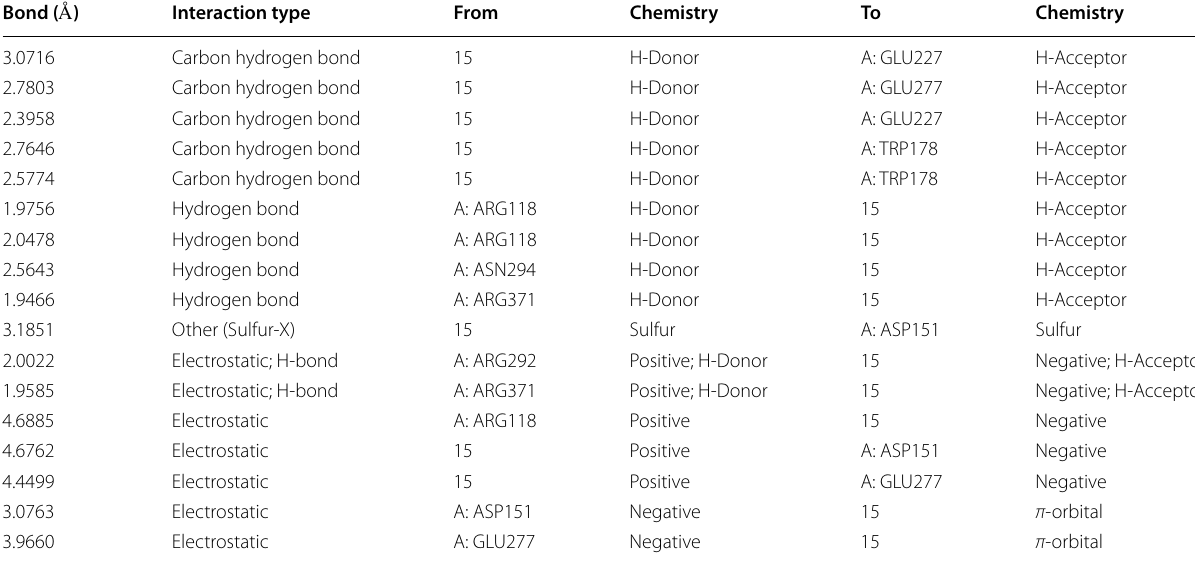
Table 14 Binding residual interaction of the H1N1 neuraminidase receptor with compound 15 Bond ( Å ) Interaction type From